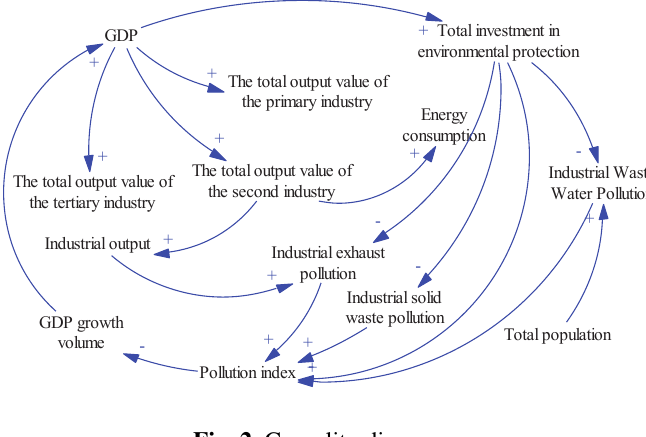
Fig. 2 Causality